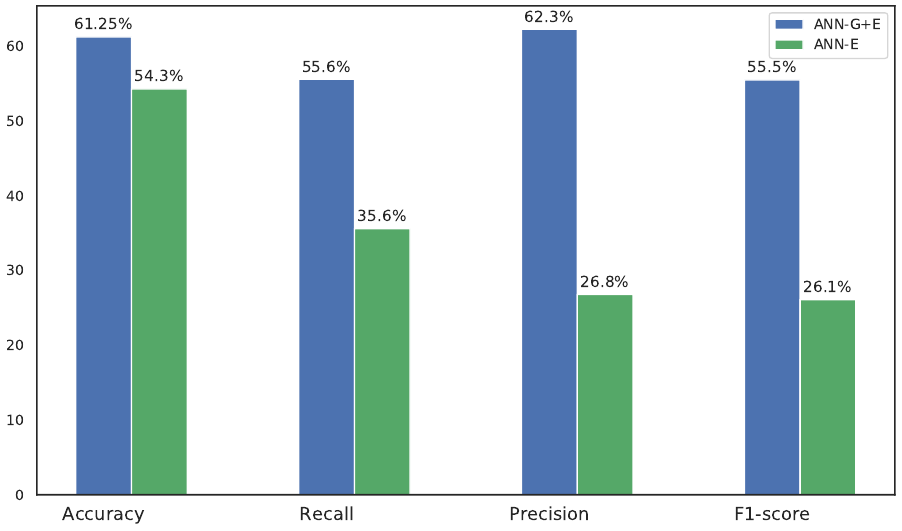
Figure 8. Overall performance metrics